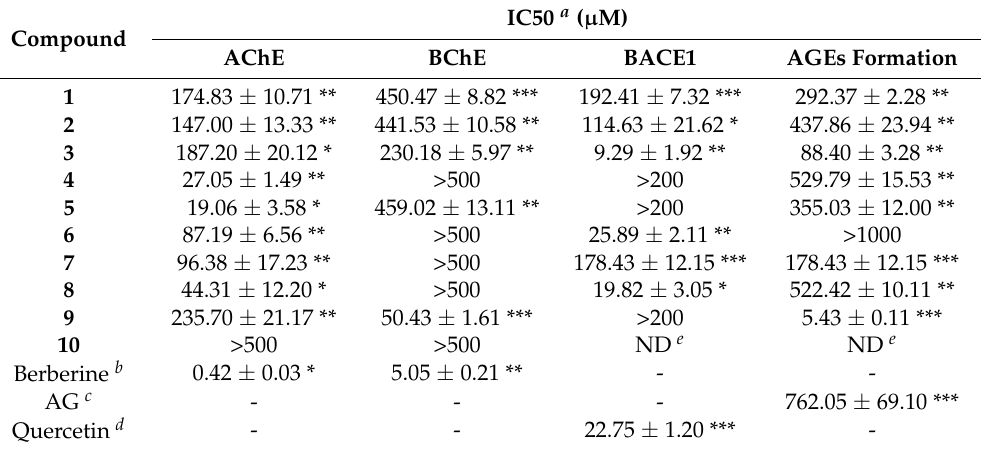
Table 3. IC 50 of the compounds 1 – 10 for acetylcholinesterase (AChE), butyrylcholinesterase (BChE), β -site amyloid precursor protein cleaving enzyme 1 (BACE1), and advanced glycation end-product (AGE)